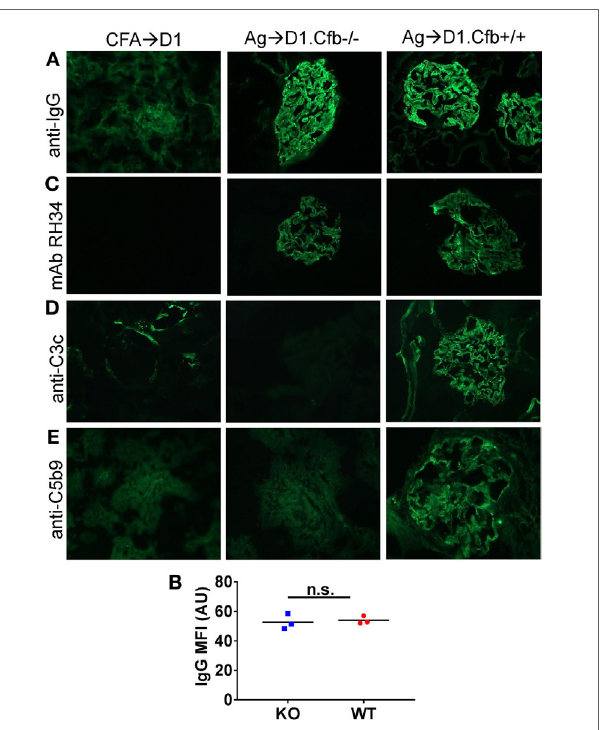
FigUre 8 | Analysis of glomerular immune complexes and complement deposition in D1 mice immunized with α 3NC1. Kidneys were collected from adjuvant immunized D1 mice (left), α 3NC1-immunized D1.Cfb − / − mice (middle), and α 3NC1-immunized D1.Cfb − / − mice (right) at week 8 after the initial immunization. (a) Immunofluorescence staining for mouse IgG shows glomerular basement membrane (GBM) staining in α 3NC1-immunized D1.Cfb − / − and D1.Cfb + / + mice. Adjuvant-immunized control mice show non-specific mesangial IgG deposition. (B) Mean fluorescence intensity (MFI) of IgG staining, expressed in arbitrary units (AU), was compared in α 3NC1-immunized D1.Cfb − / − and D2.Cfb + / + mice. The difference was not significant (n.s.) by t test. (c) Staining with mAb RH34 shows the GBM deposition of exogenous antigen in both groups of α 3NC1-immunized mice, which is absent in control mice. (D) Direct immunofluorescence staining reveals capillary loop deposition of C3c in α 3NC1-immunized D1.Cfb + / + mice, while C3c staining is absent in D1.Cfb − / − mice. (e) Indirect immunofluorescence shows C5b-9 deposition along the GBM in α 3NC1-immunized D1.Cfb + / + mice but not D1.Cfb − / − mice. Original magnification 400 ×